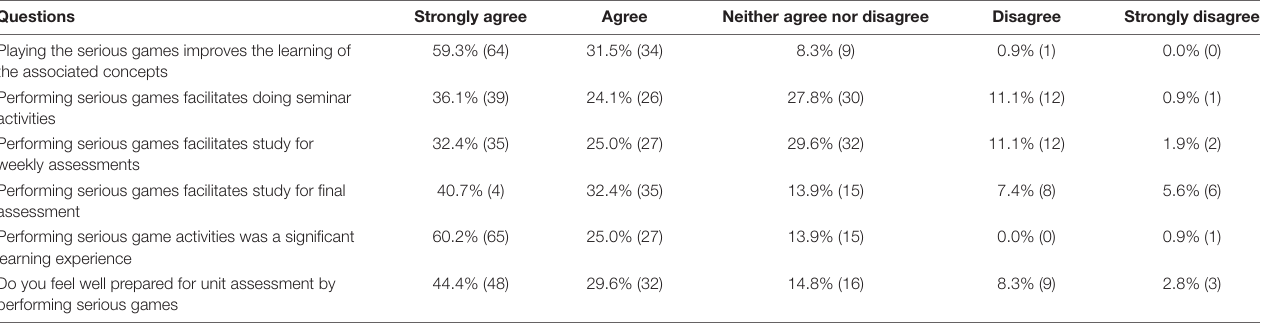
TABLE 3 | Percentage of responses to questions on academic